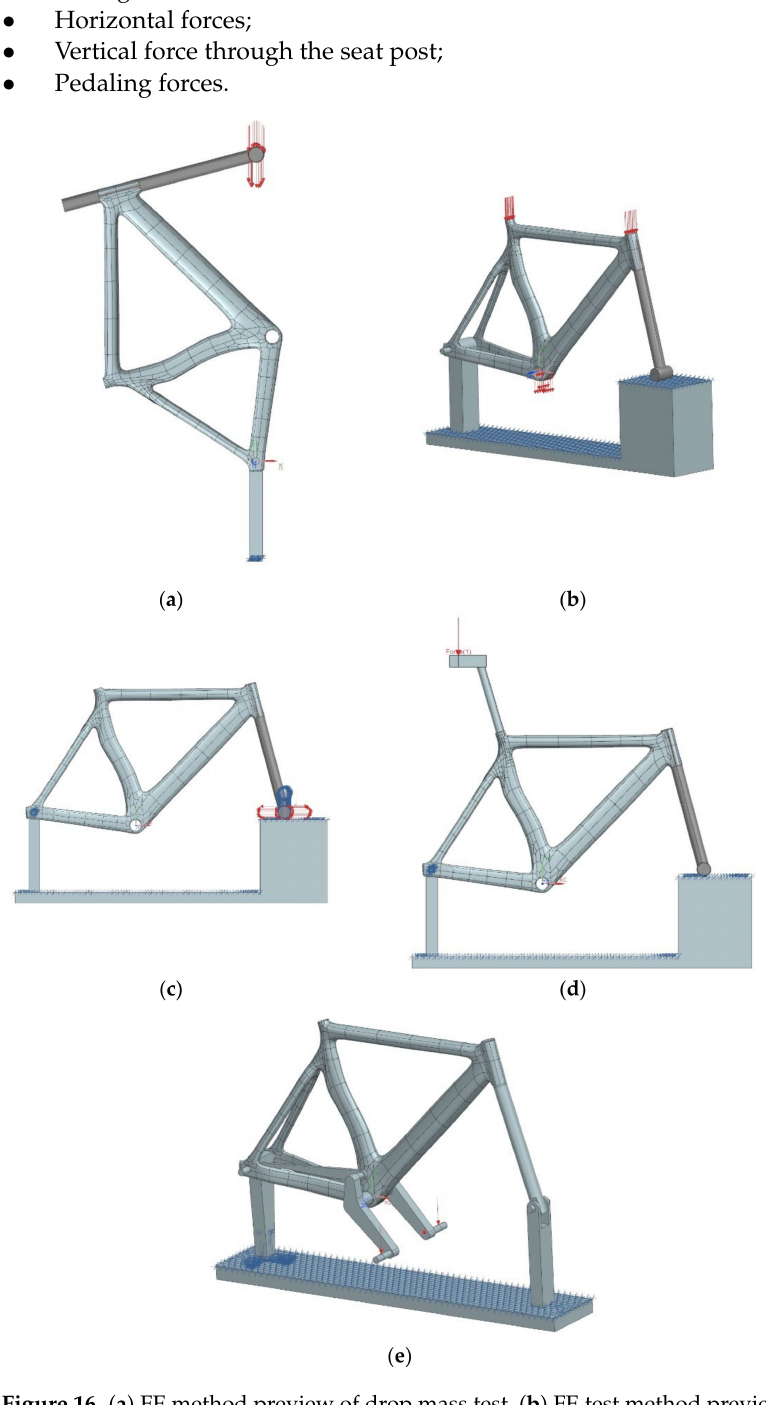
Figure 16. ( a ) FE method preview of drop mass test, ( b ) FE test method preview of the falling frame, ( c ) FE test method preview of horizontal forces, ( d ) FE test method preview of vertical force through the seat tube, ( e ) FE test method preview of pedaling